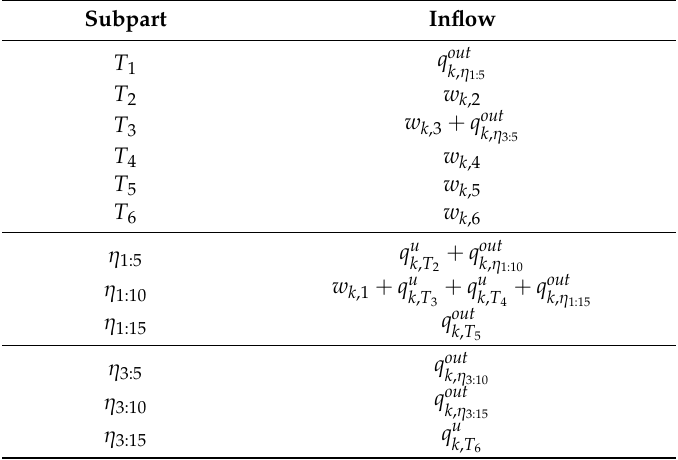
Table 2. Inflows to the di ff erent elements of the